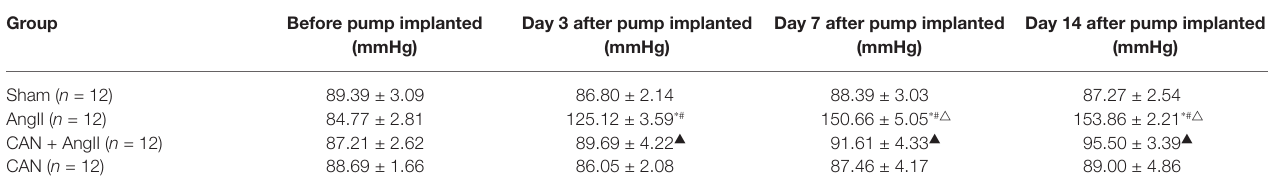
TABLE 1 | Systolic blood pressure in each group of